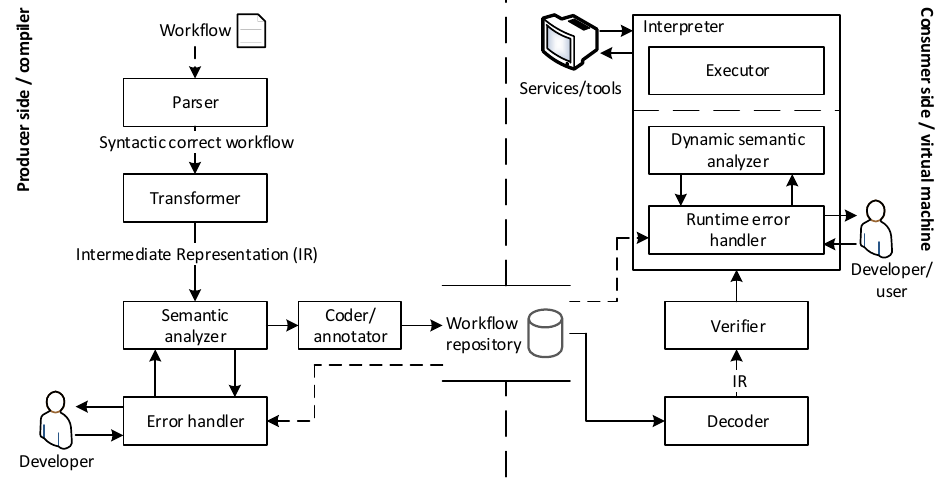
Figure 21. Map of a system for developing and executing workflows (adapted from